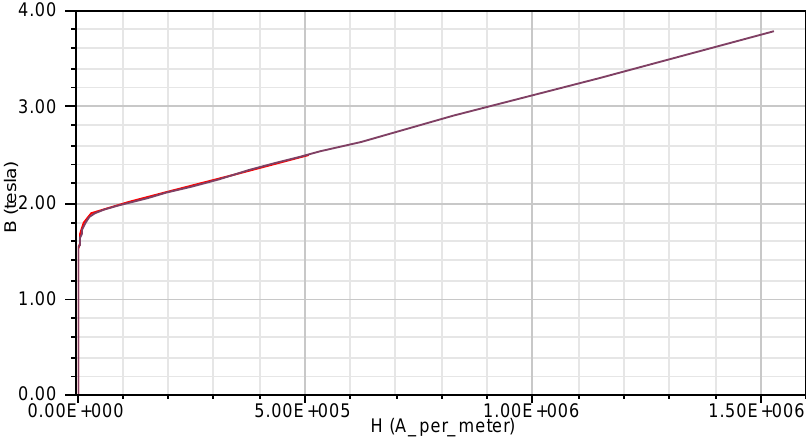
Figure 6. B–H curve of the used steel in the rotor disc. The characteristic curve of this alloy indicates that the knee point occurs at 1.85 Tesla.